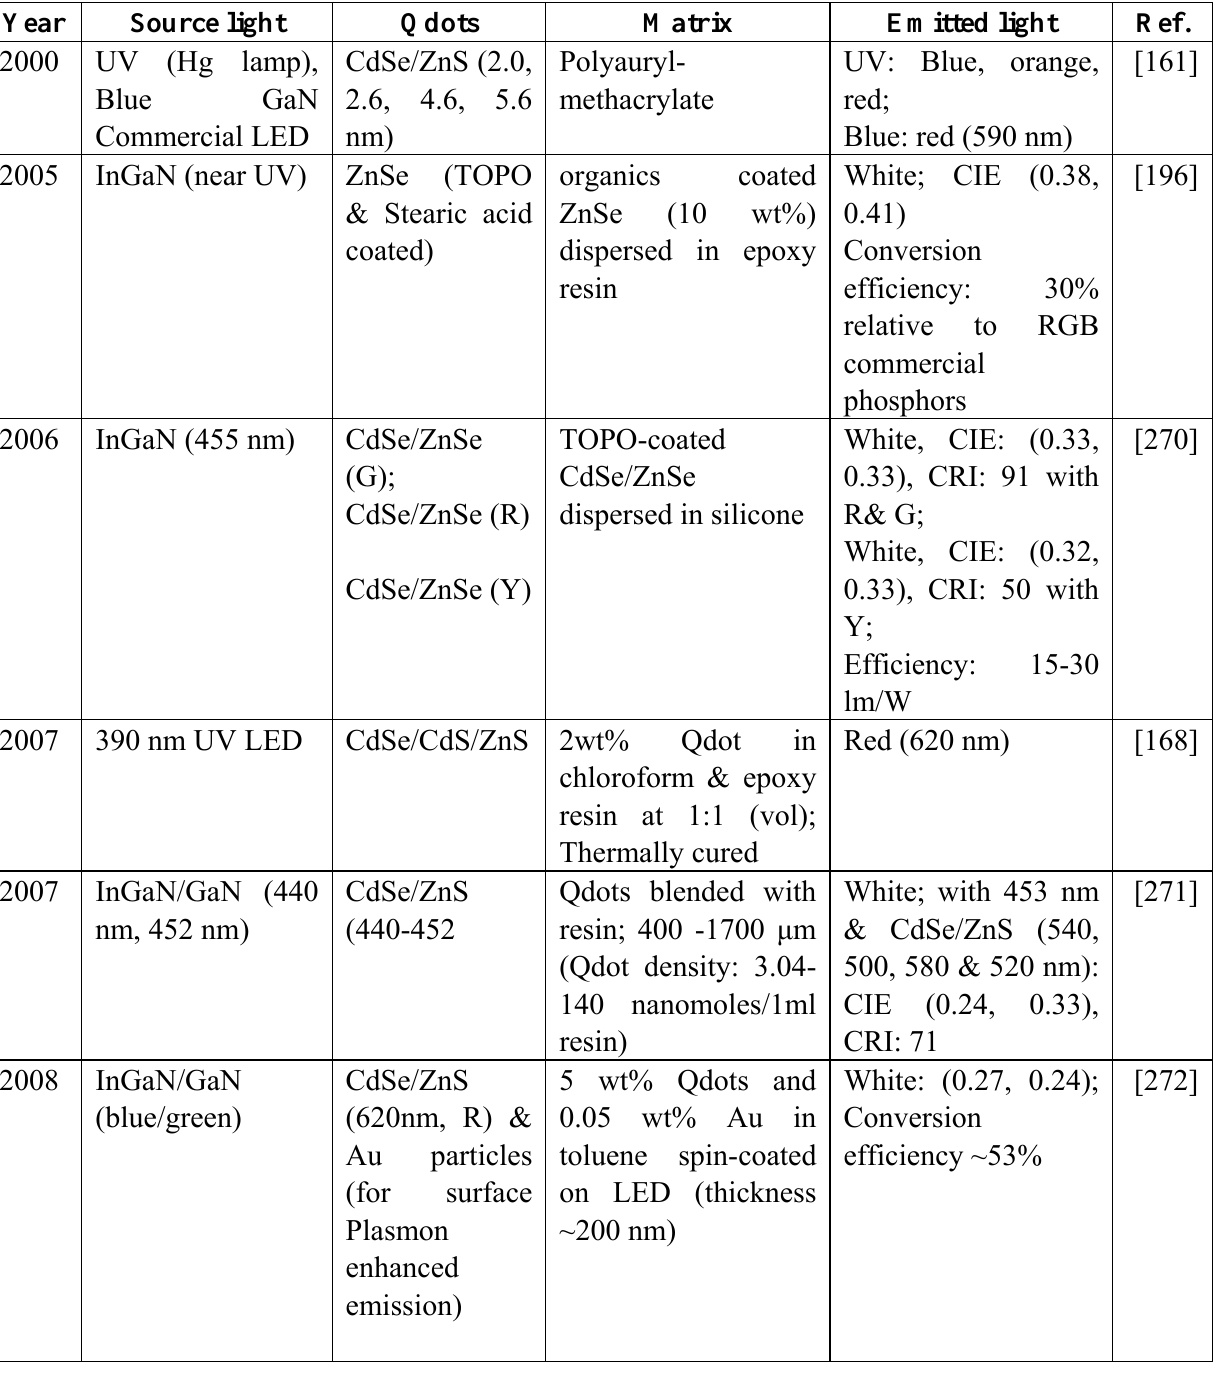
Table 8. Selected reports on the use of Qdots to downconvert blue or UV light from inorganic